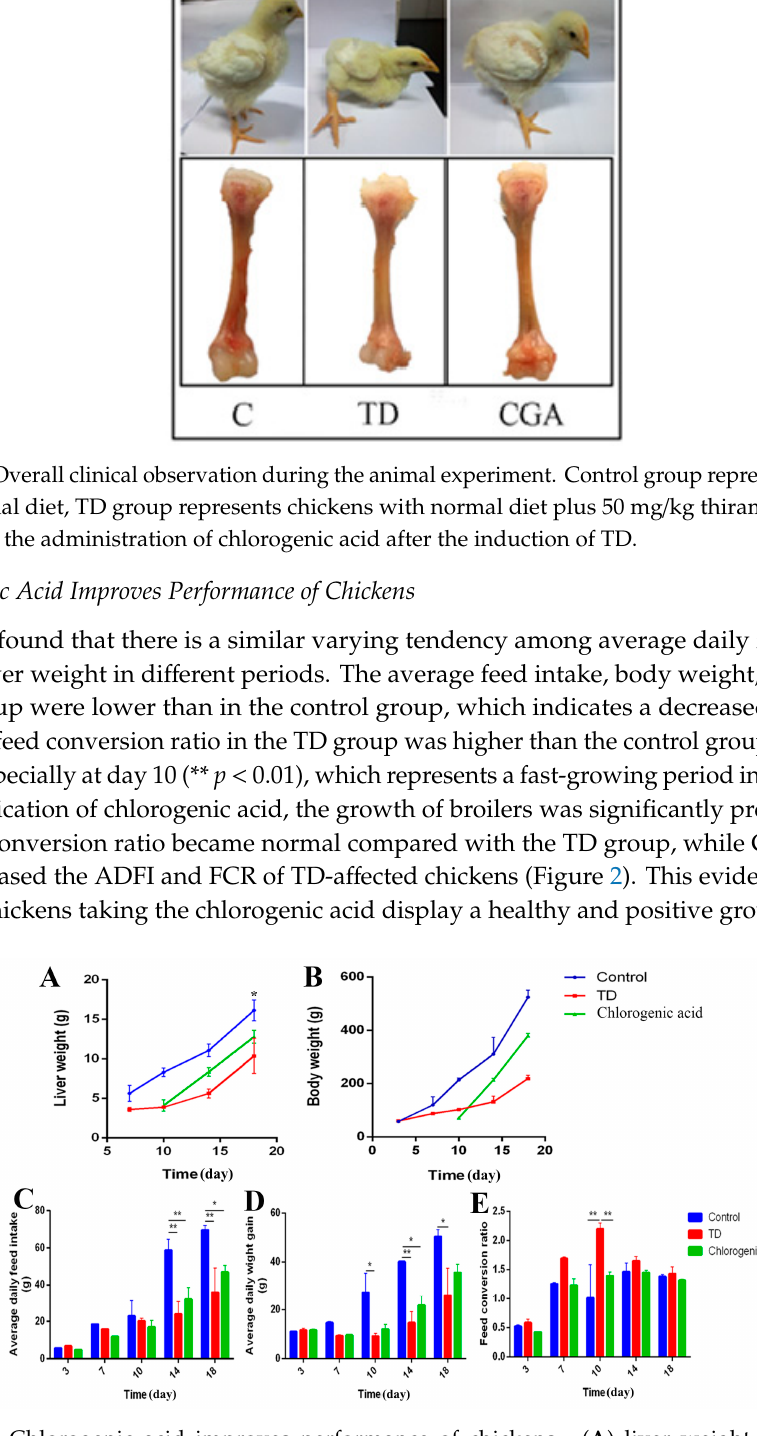
Figure 2. Chlorogenic acid improves performance of chickens. ( A ) liver weight measured on slaughtering days 7, 10, 14 and 18. * represents the difference between control group and TD group, * p < 0.05. ( B ) The body weight was recorded from the first day to the 18th, CGA can improve the body weight of TD affected chickens. ( C – E ) The average daily feed intake (ADFI), average daily weight gain (ADWG) and feed conversion ratio (FCR) were calculated from the first day to the 18th, TD decreased the ADFI and ADWG of chickens, the administration of CGA reverse this condition. The data are expressed as means ± SD. * p < 0.05, ** p <